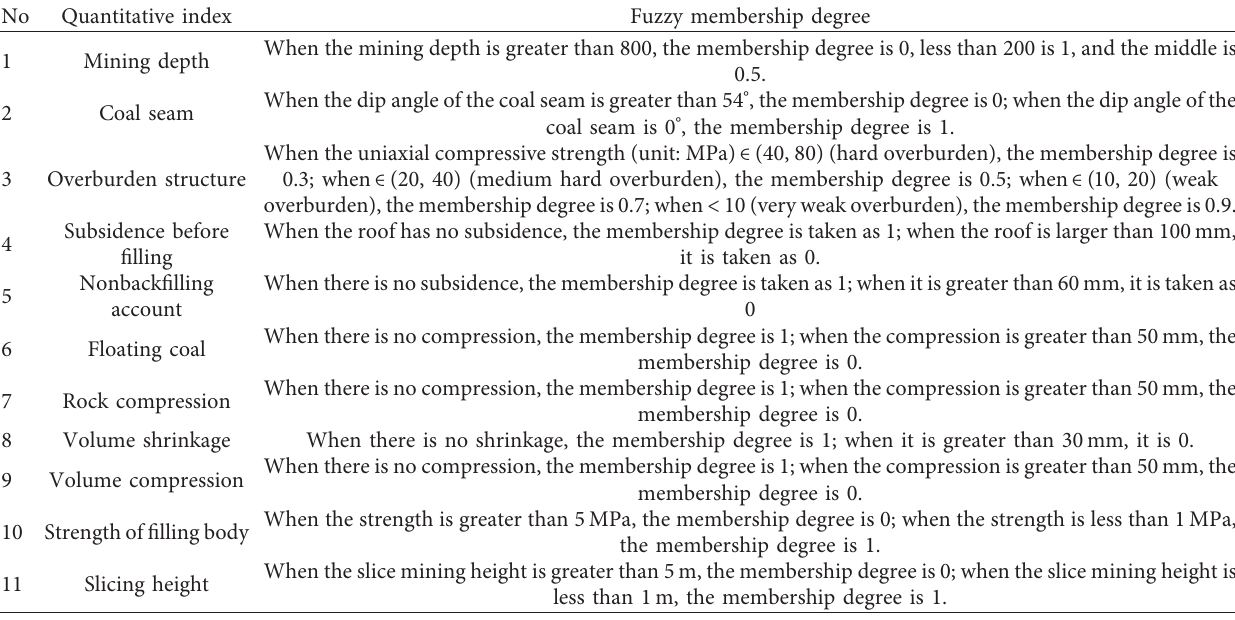
Table 2: Fuzzy membership degree of quantitative